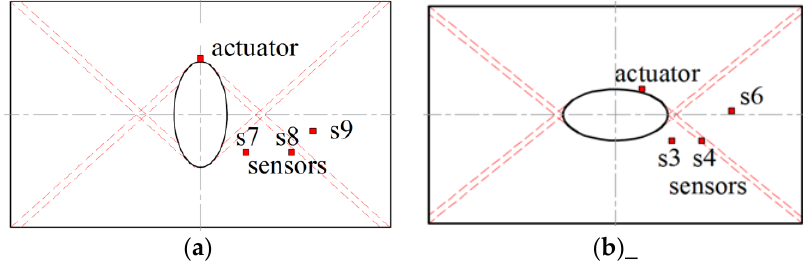
Figure 10. Configurations of actuators and sensors (the piezoelectric (PZT) disks for vertical ( a ) and horizontal ( b ) elliptical hole are visible as dark shadows in Figure 4) — the red dotted lines show the directions of cracks at 45° or − 45°.